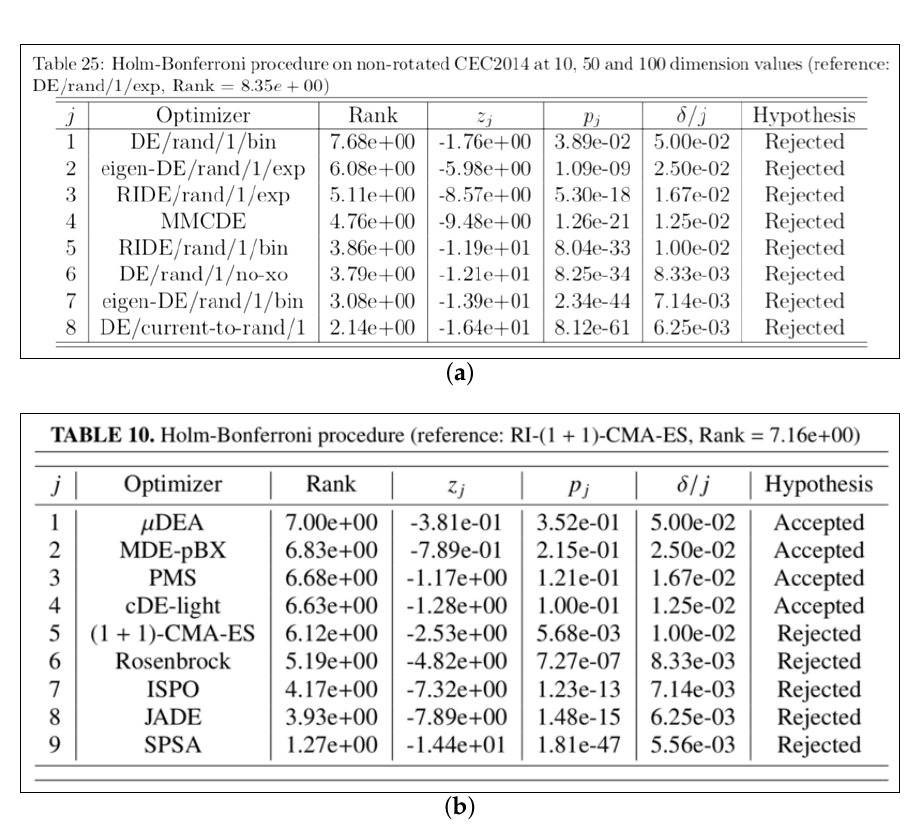
Figure 9. Two examples of TableHolmBonferroni tables. In ( a ), some results from the study in [4] obtained over the non-rotated functions of the R-CEC14 benchmark suite presented in Section 3. More examples are available in the extended results files stored in the repository [99]. In ( b ), some results from the study in [73] obtained over the functions of the CEC 2014 benchmark suite [2]. Extended results for this study are available in the repository